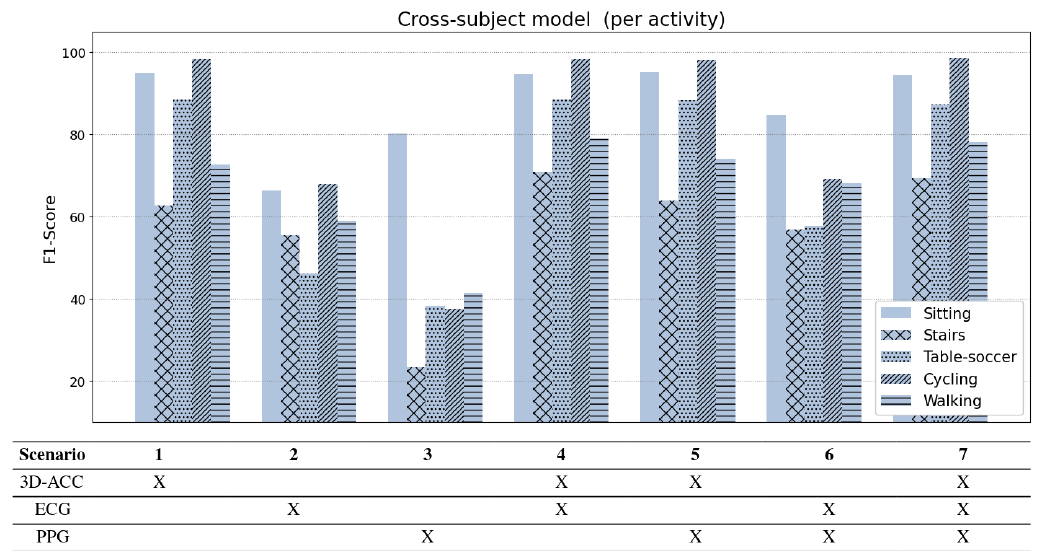
Figure 8. Cross-subject model results per